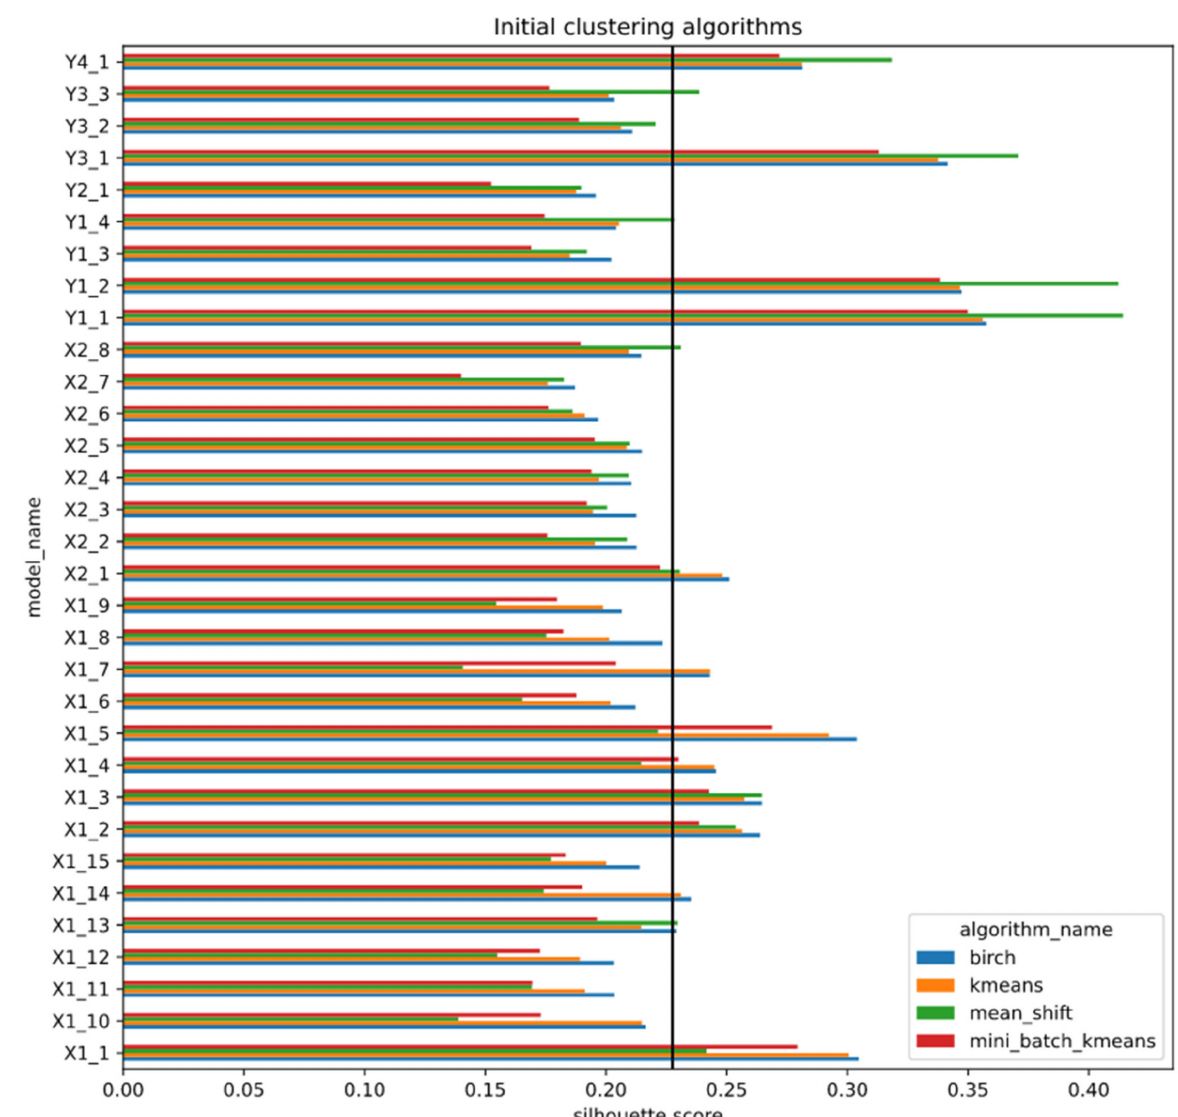
Figure 6. The initial clustering algorithm mean silhouette score result bar plots based on used models and algorithms with the black line indicating average silhouette